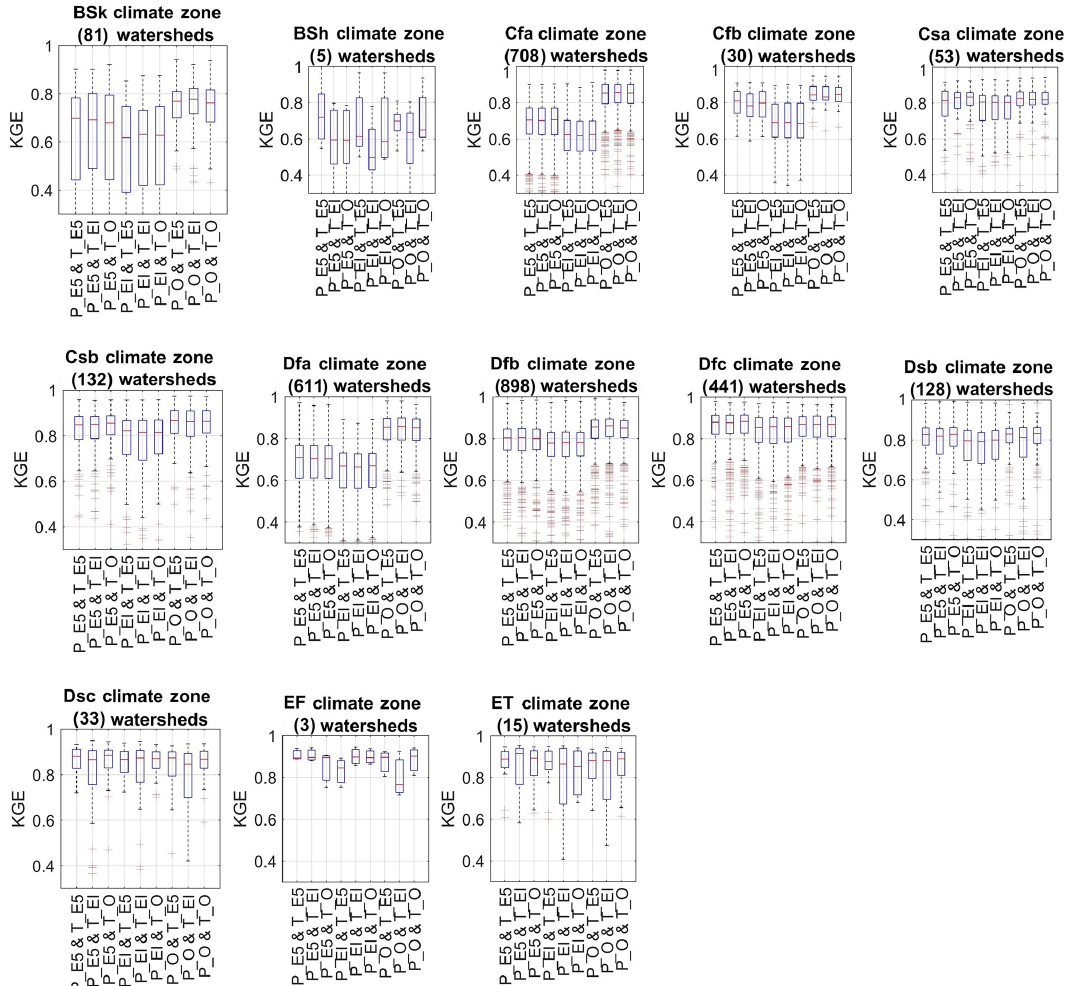
Figure 10. Distribution of the Kling–Gupta efficiency metrics for the 13 climate zones of Fig. 9, for hydrological model HMETS.